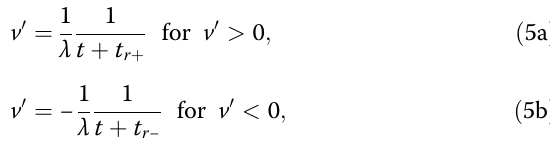
and t r − are arbitrary time constants. We sup- where t r + pose a motionless ship is forced by transient tsunami current ( v c ) in the HDG-normal direction, and consider the response of the ship velocity ( v ) to the tsunami current. A proper condition is v ′ = v c at t = 0, and v ′ = 0 at t = ∞ , which determines the constants. Then,